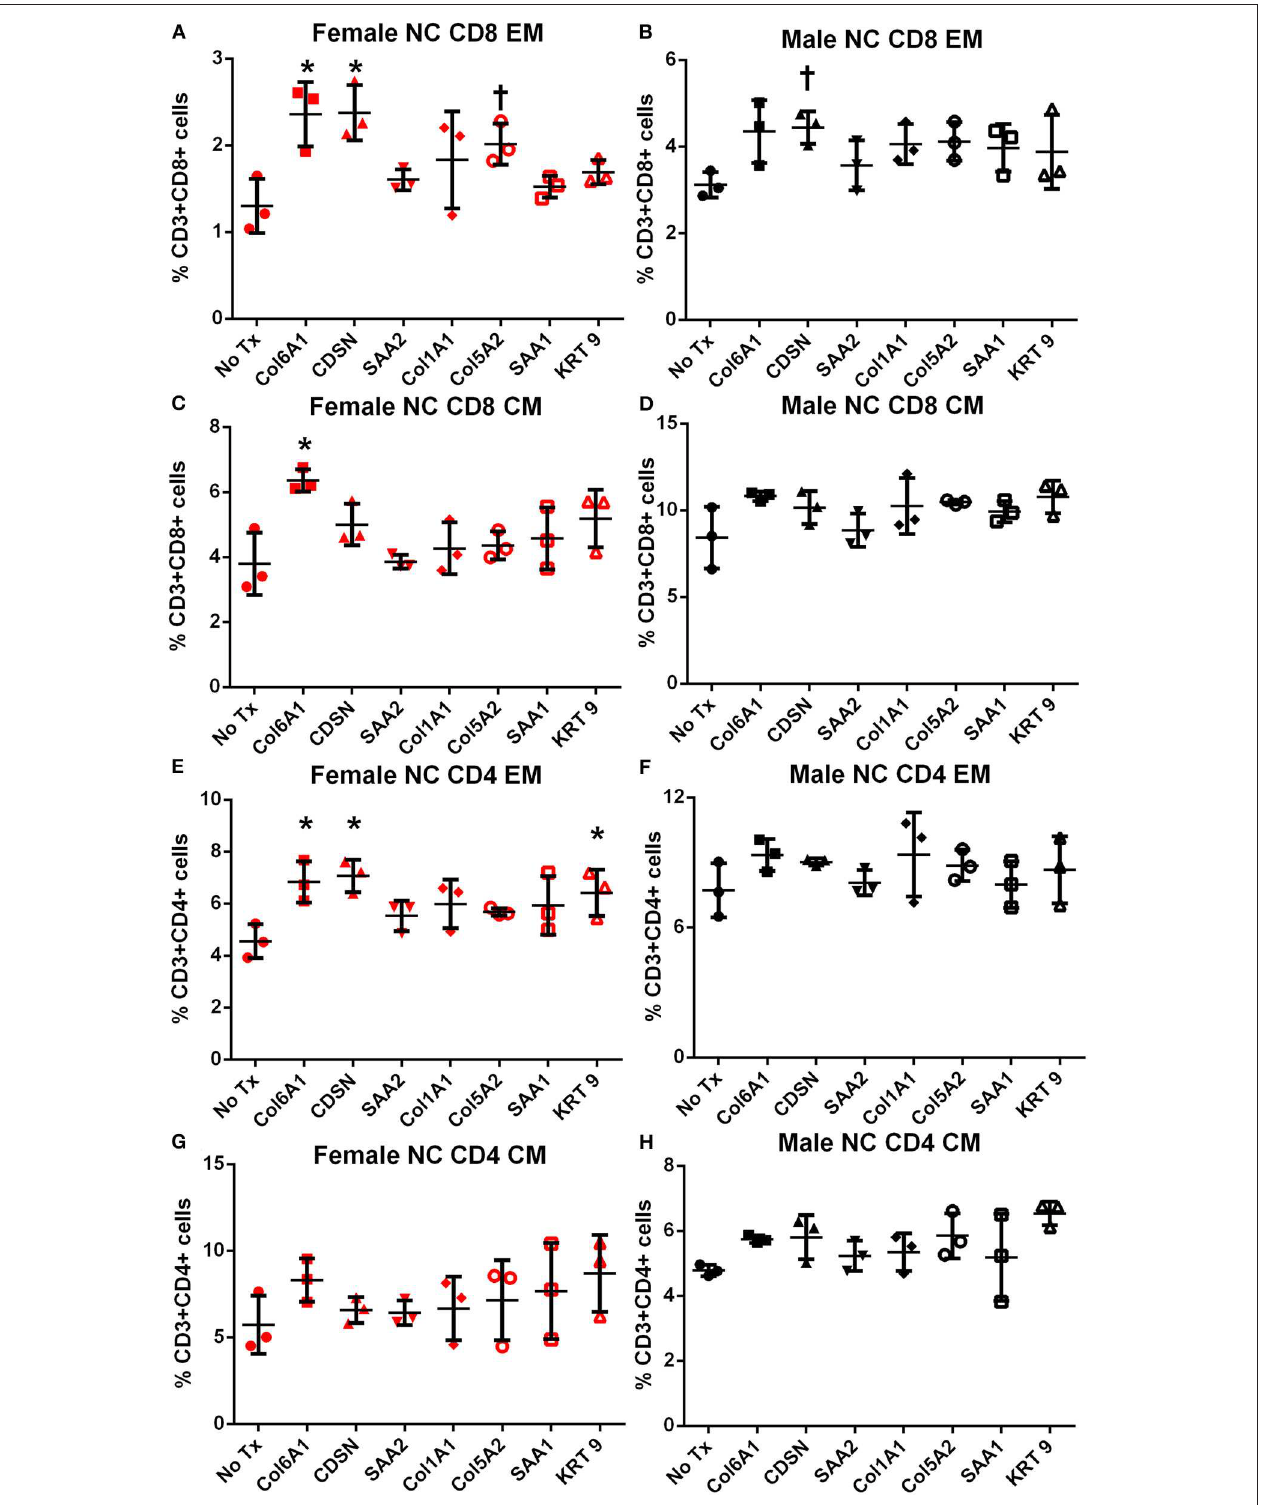
FIGURE 4 | Memory T cell response to peptide stimulation of splenocytes from normal chow-fed mice. Splenocytes from female (A,C,E,G) or male (B,D,F,H) apoE–/– mice fed normal chow (NC) for 6 weeks stimulated with mouse homologs of self-peptides or no stimulation (No Tx) for 24h and then stained for Effector Memory (EM) or Central Memory (CM) T cells. N = 3 each; * P < 0.05, † P = 0.06 compared to No Tx. Gating scheme depicted in Figure S2 .